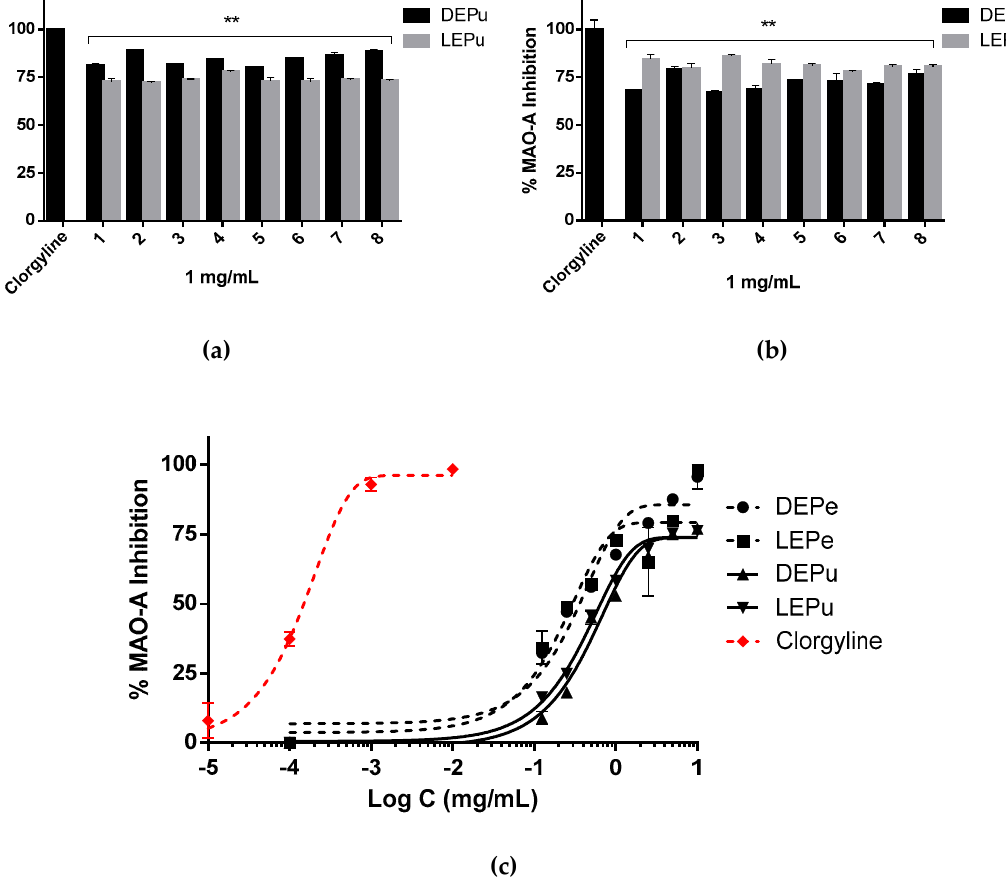
Figure 3. MAO ‐ A inhibition: ( a ) inhibition performed by extracts obtained from pulp ( n = 3); ( b ) inhibition performed by extracts obtained from peel ( n = 3); ( c ) inhibition performed by sample 8 obtained from pulp, peel and clorgyline in a concentration dependent manner ( n = 3). One ‐ way analysis of variance (ANOVA) followed by Dunnet’s test for multiple comparisons: ** p < 0.01 against clorgyline. DEPe: dried peel methanolic extract; LEPe: lyophilized peel methanolic extract; DEPu: dried pulp methanolic extract; LEPu: lyophilized pulp methanolic extract.